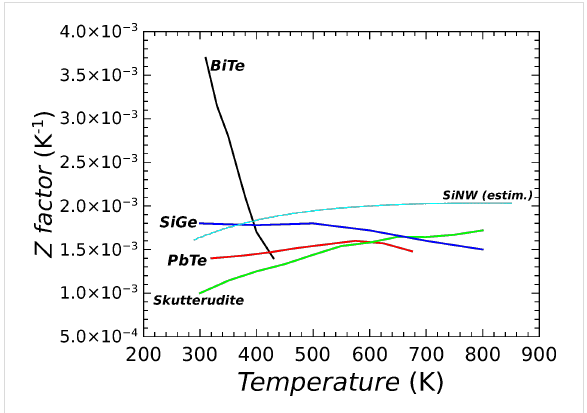
Figure 4: The Z parameter is reported as a function of temperature for few most common TE materials (n type). Experimental data from litera- ture have been used, and in particular: curve BiTeSe from [23]; PbTe from [28]; skutterudites from [37]; and SiGe from [38]. Numerical esti- mation of the Z parameter for a silicon nanowire 50 nm wide and n-doped 5 × 10 19 cm − 3 is also